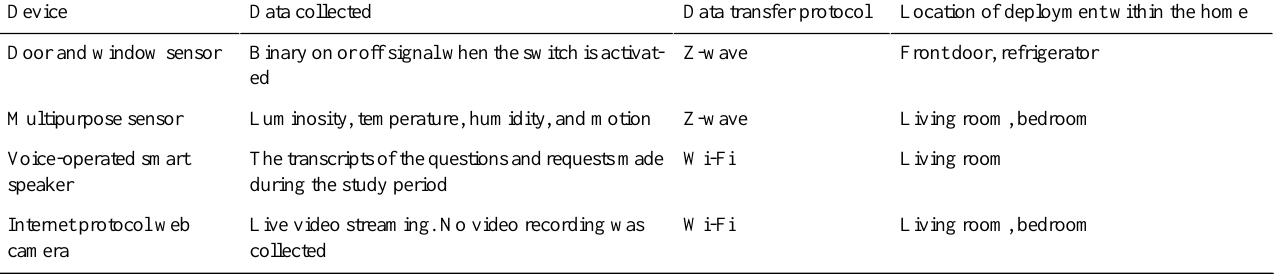
Table 1. Internet-of-Things smart home devices used in this study.